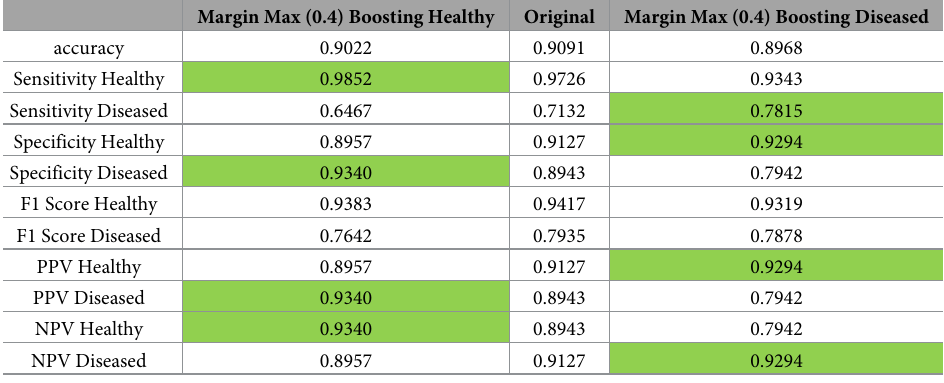
Table 7. Sensitivity boost of the ‘curated’ dataset with two labels, for healthy and diseased categories.